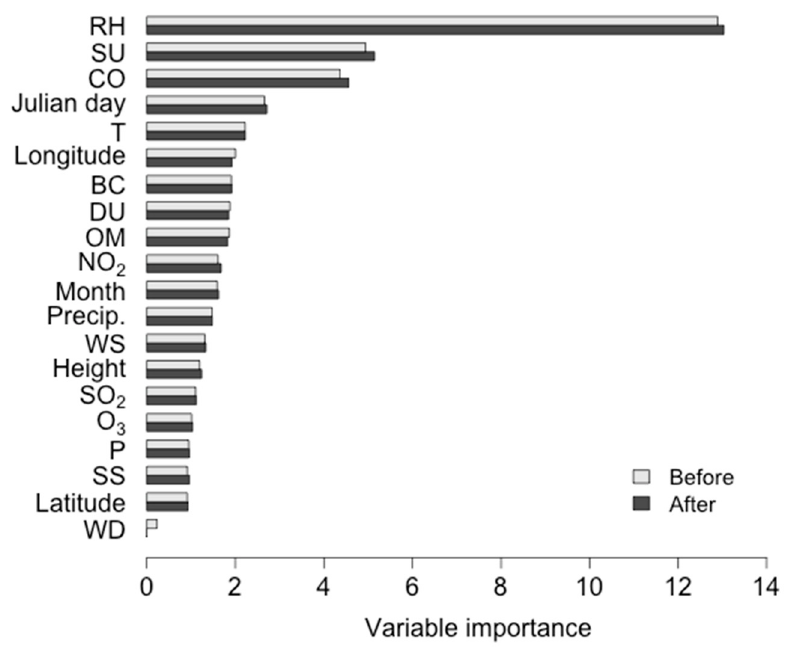
Figure 3. Relative importance of meteorological variable inputs in the random forest model. “Before” and “after” mean the change in importance before and after removing WD are shown.